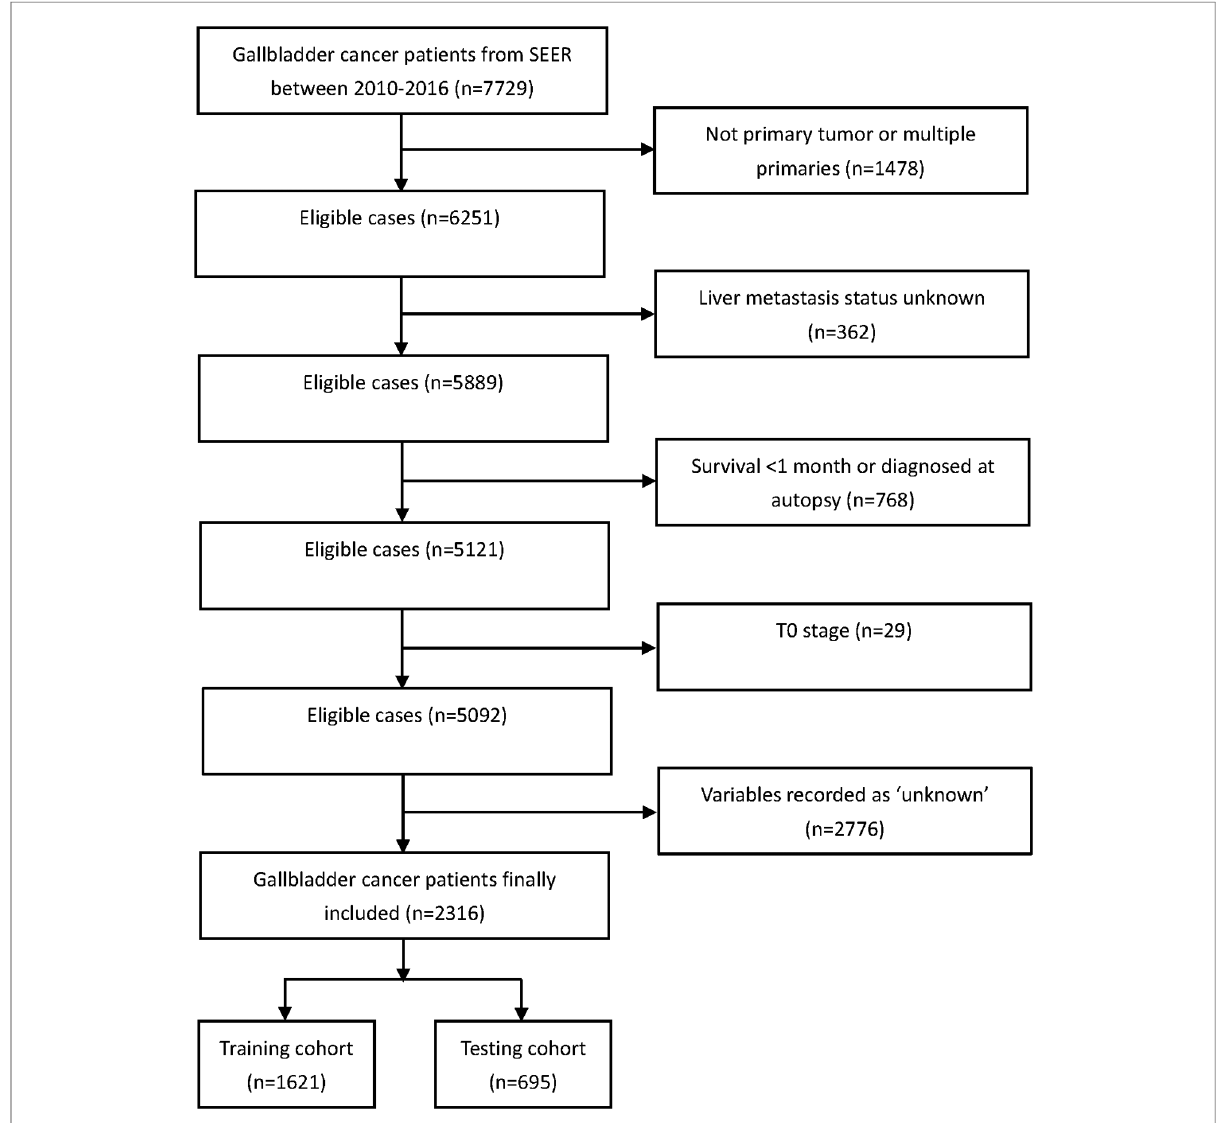
FIGURE 1 Inclusion fl owchart of gallbladder cancer patients from the SEER